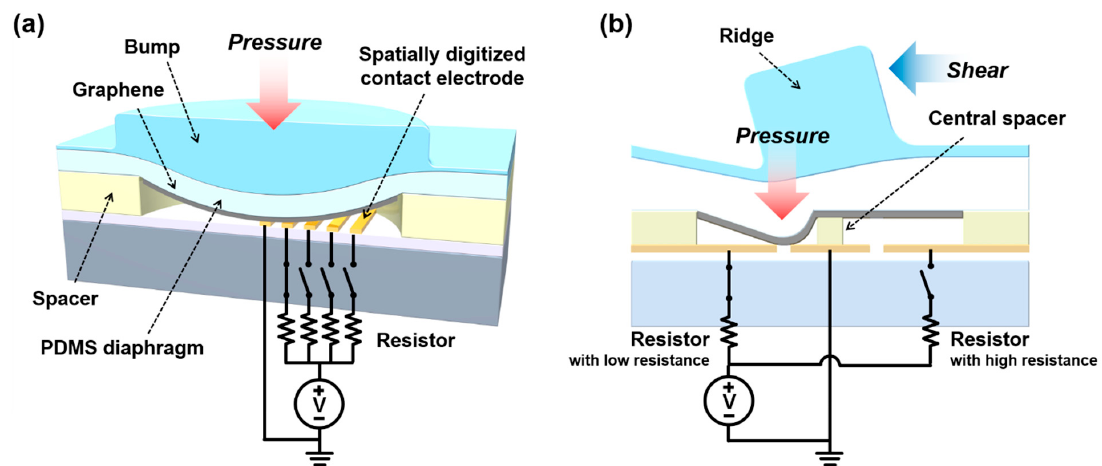
Figure 1. The schematic illustration of a pressure sensor unit and a shear sensor unit integrated on the TIS: ( a ) 3D cross- sectional schematic diagram showing the operating mechanism of the pressure sensor unit; ( b ) cross-sectional schematic diagram showing the shear detecting mechanism of the shear sensor unit.